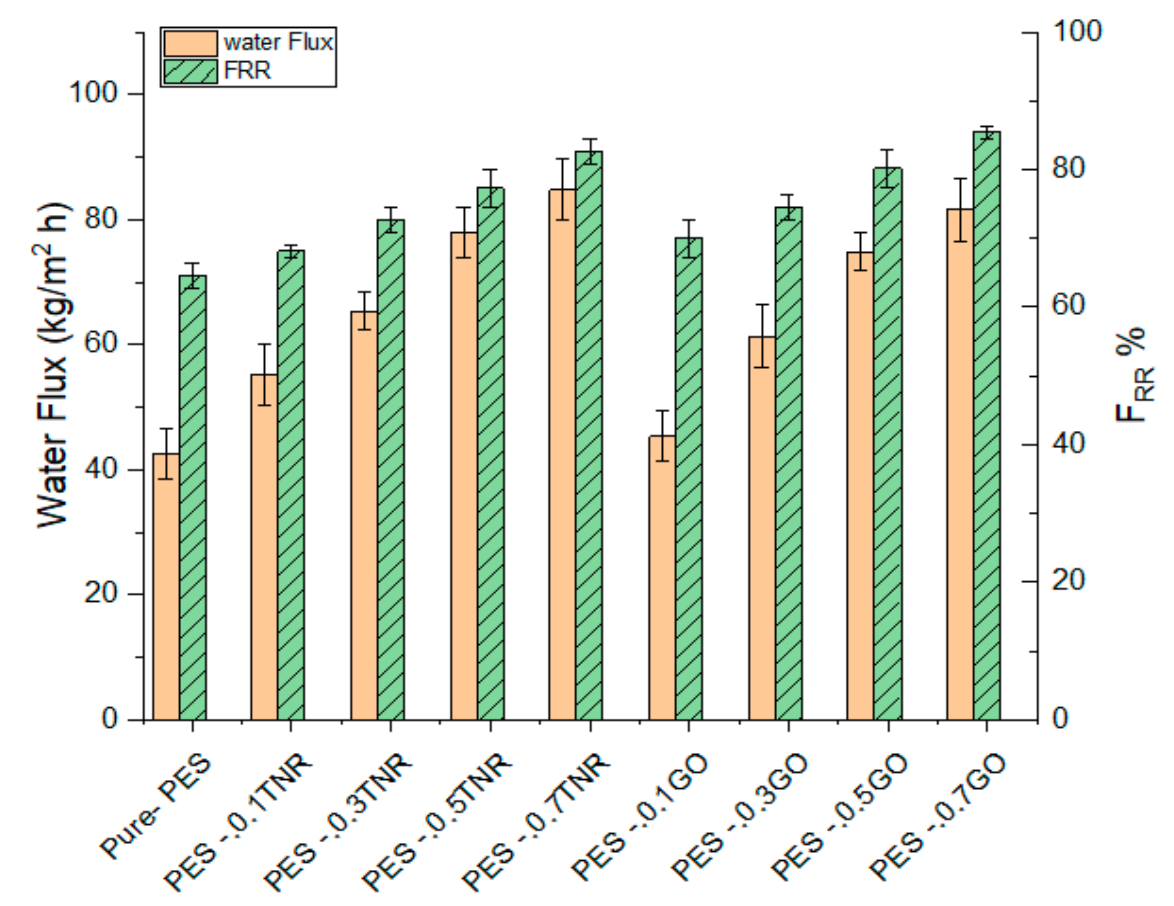
Figure 6. Pure water flux and the flux recovery ratio of synthesized pure-PES, PES-TNR, and PES- GO membranes.